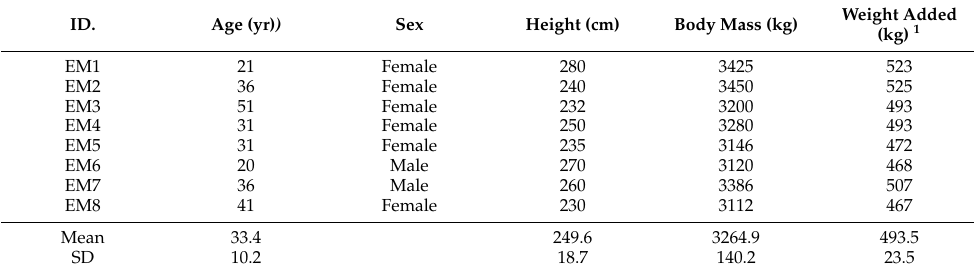
Table 1. Demographic data and weight carriage loads of eight Asian elephants used in this study.